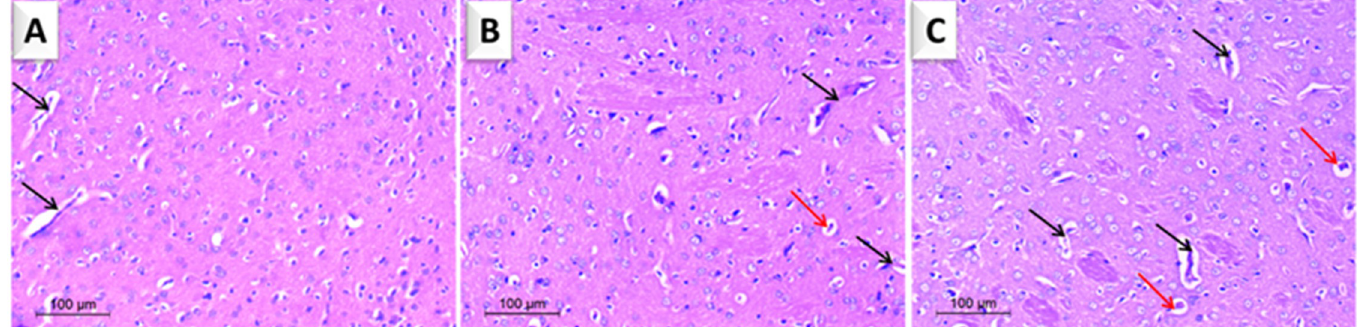
Fig 5. Photomicrographs of rat striatum (H & E, 100). (A) Normal neurons with some blood vessels as a control (black arrows). ( B ) Low dose Yucca (50 mg/kg) and ( C ) high dose yucca (100 mg/kg): perineuronal vacuolation (red arrows), blood vessel (black arrows).